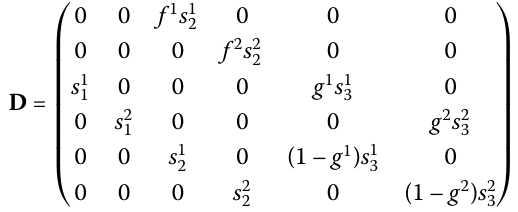
Defining G ( X ) = U X and and the reduced system associated to (12) is